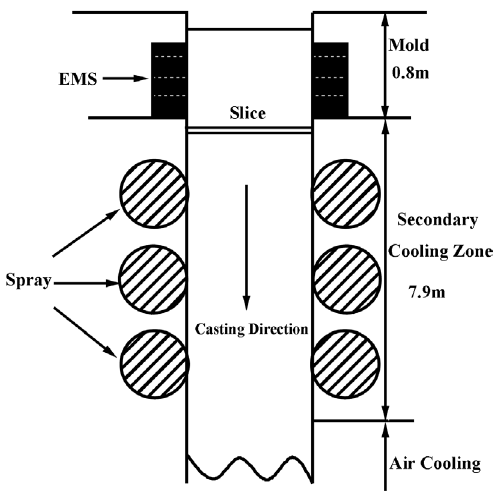
Fig. 1: Schematic illustration of boundary conditions and the moving slice